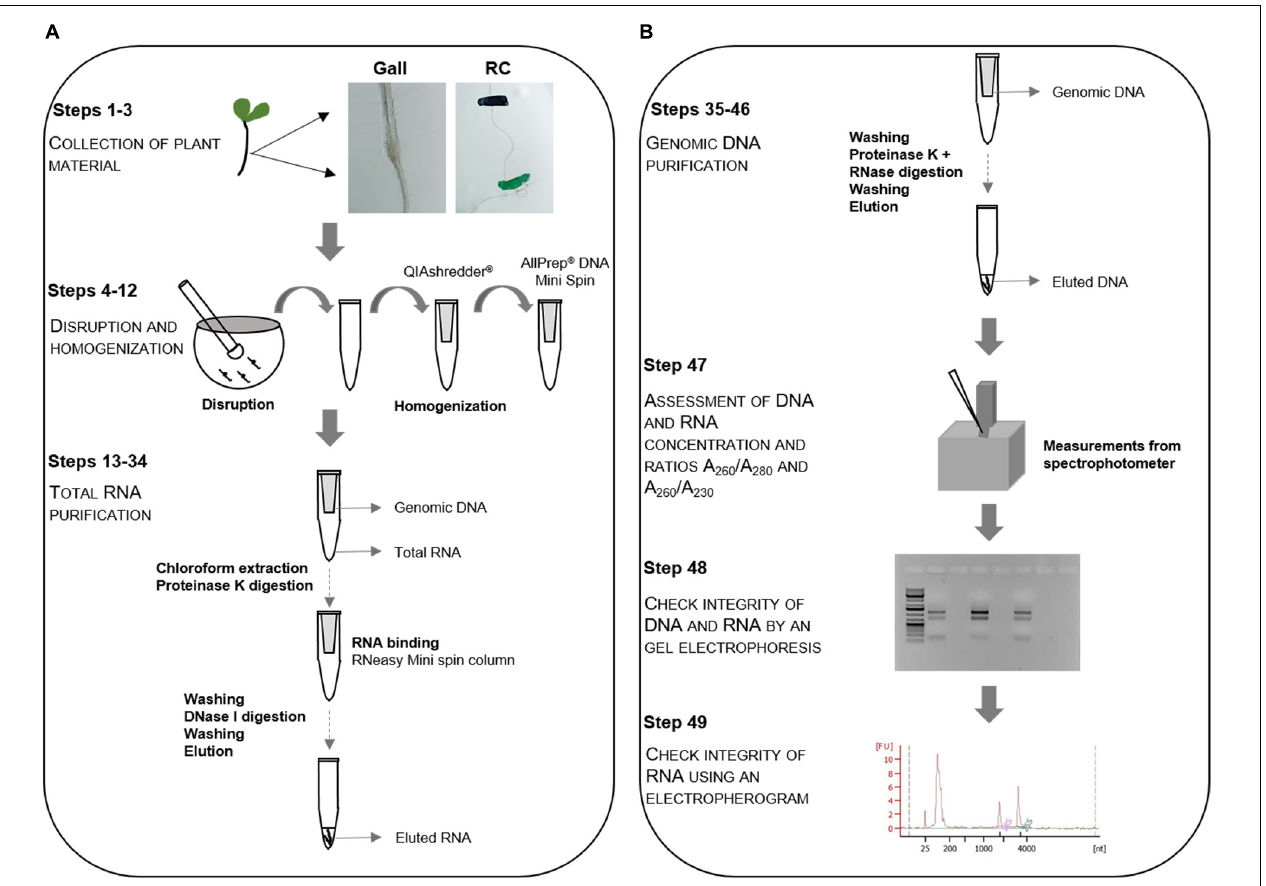
FIGURE 1 | Flowchart of the RNA/DNA extraction procedure. Schematic flowchart for the simultaneous extraction of genomic DNA and total RNA from galls induced by Meloidogyne javanica and its respective control root regments (RC). (A) Plant material is collected, disrupted in a mortar and pestle and homogenized using a QIAshredder R (cid:13) spin column followed by the total RNA purification. The primary root segments of uninfected plants in equivalent positions to that of the galls in infected plants are considered as control root tissue (steps 1–3). (B) RNA purification is followed by purification of the genomic DNA (steps 4–46). Assessment of DNA and RNA purity, quality and integrity is performed in steps